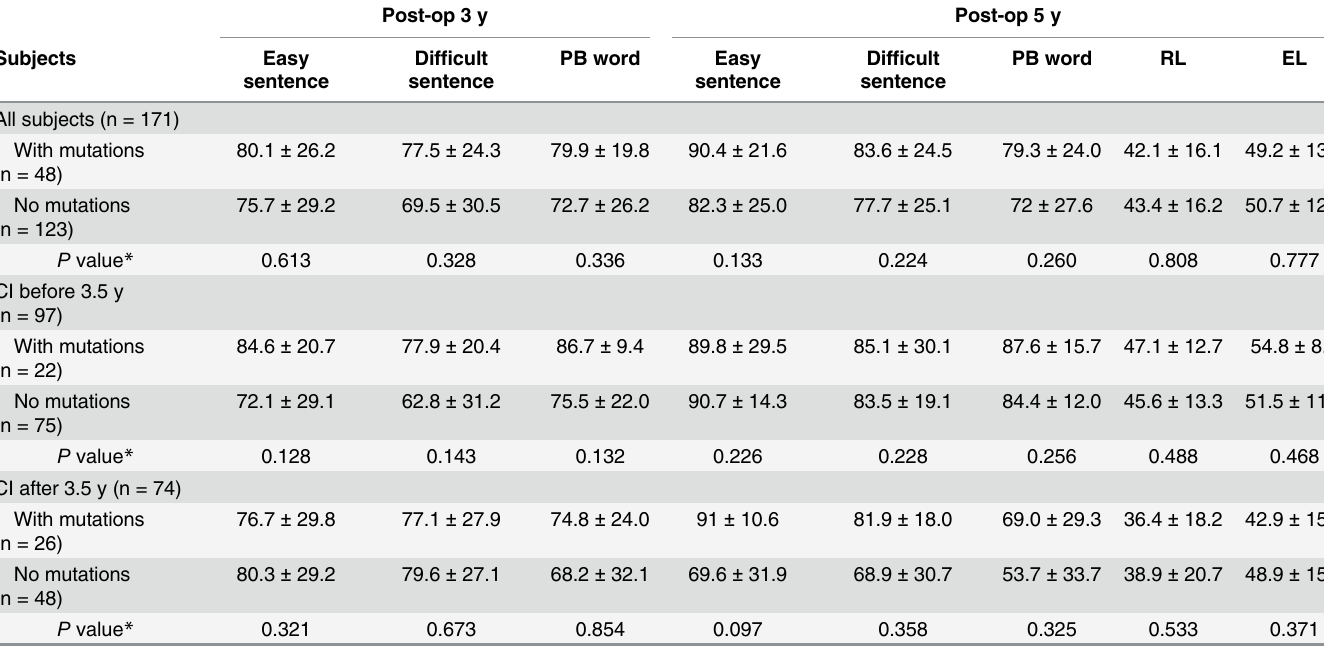
Table 6. Speech perception and language skill measures in all subjects, subjects implanted before the age of 3.5 years and subjects implanted after 3.5. Post-op 3 y Post-op 5